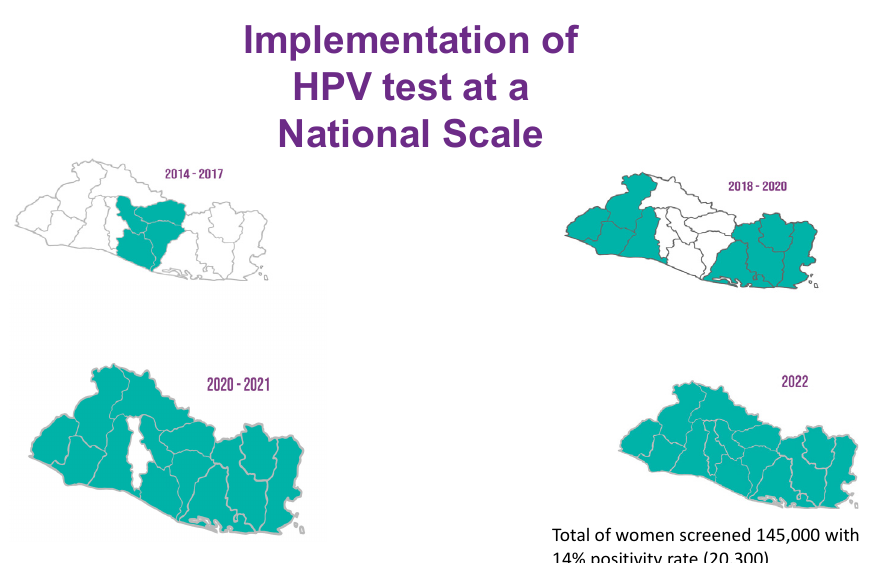
Figure 1. National scale-up of the primary HPV screen-and-treat program in El Salvador. Multi-disciplinary health teams form the backbone of the HPV screening program.